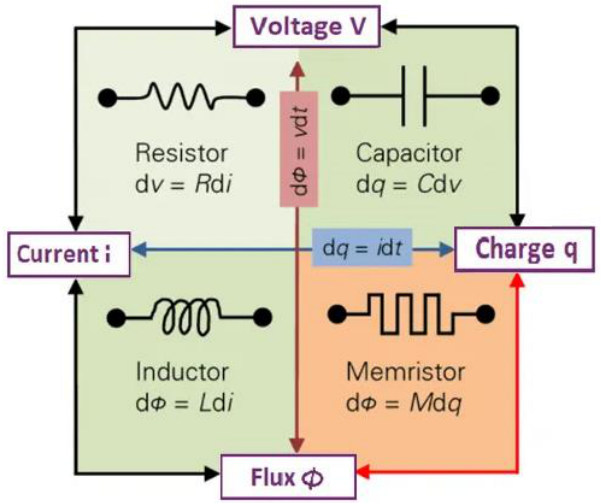
Figure 1. Memristor presentation. Four elements are given: resistor, capacitor, inductor and memristor, with their circuit representations (https://www.britannica.com/technology/memristor).